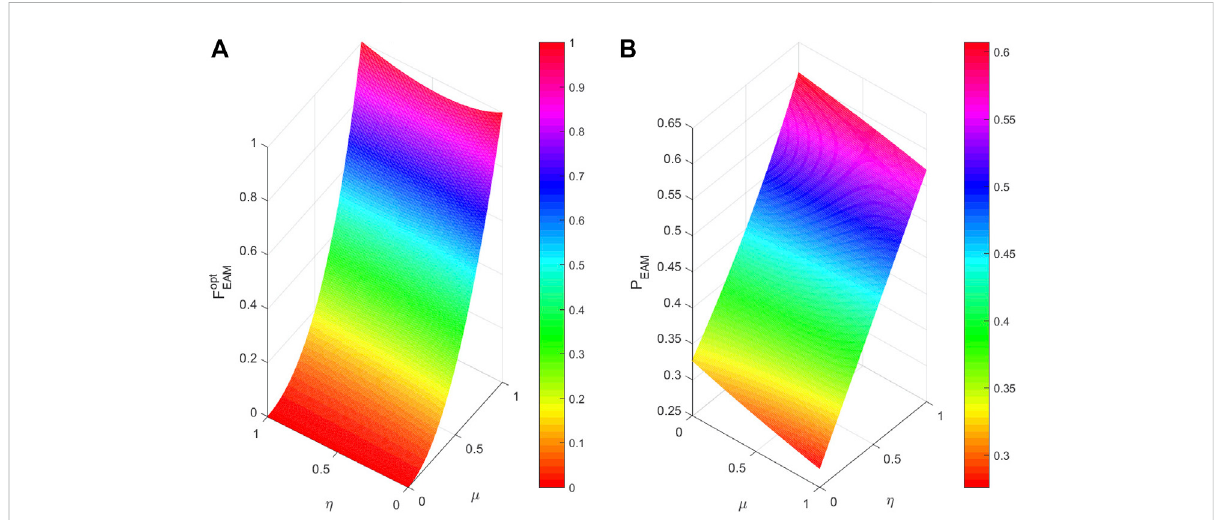
FIGURE 7 (color online) (A) Teleported F opt EAM as a function of μ and η . (B) The success probability P EAM as a function of μ and η . The QMR strength q opt